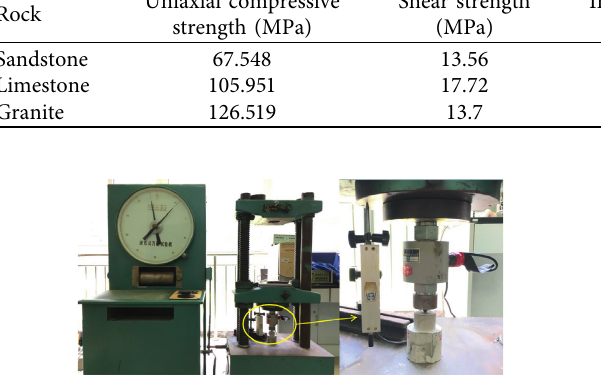
Figure 3: Process graph for the static-pressure breaking experiment.